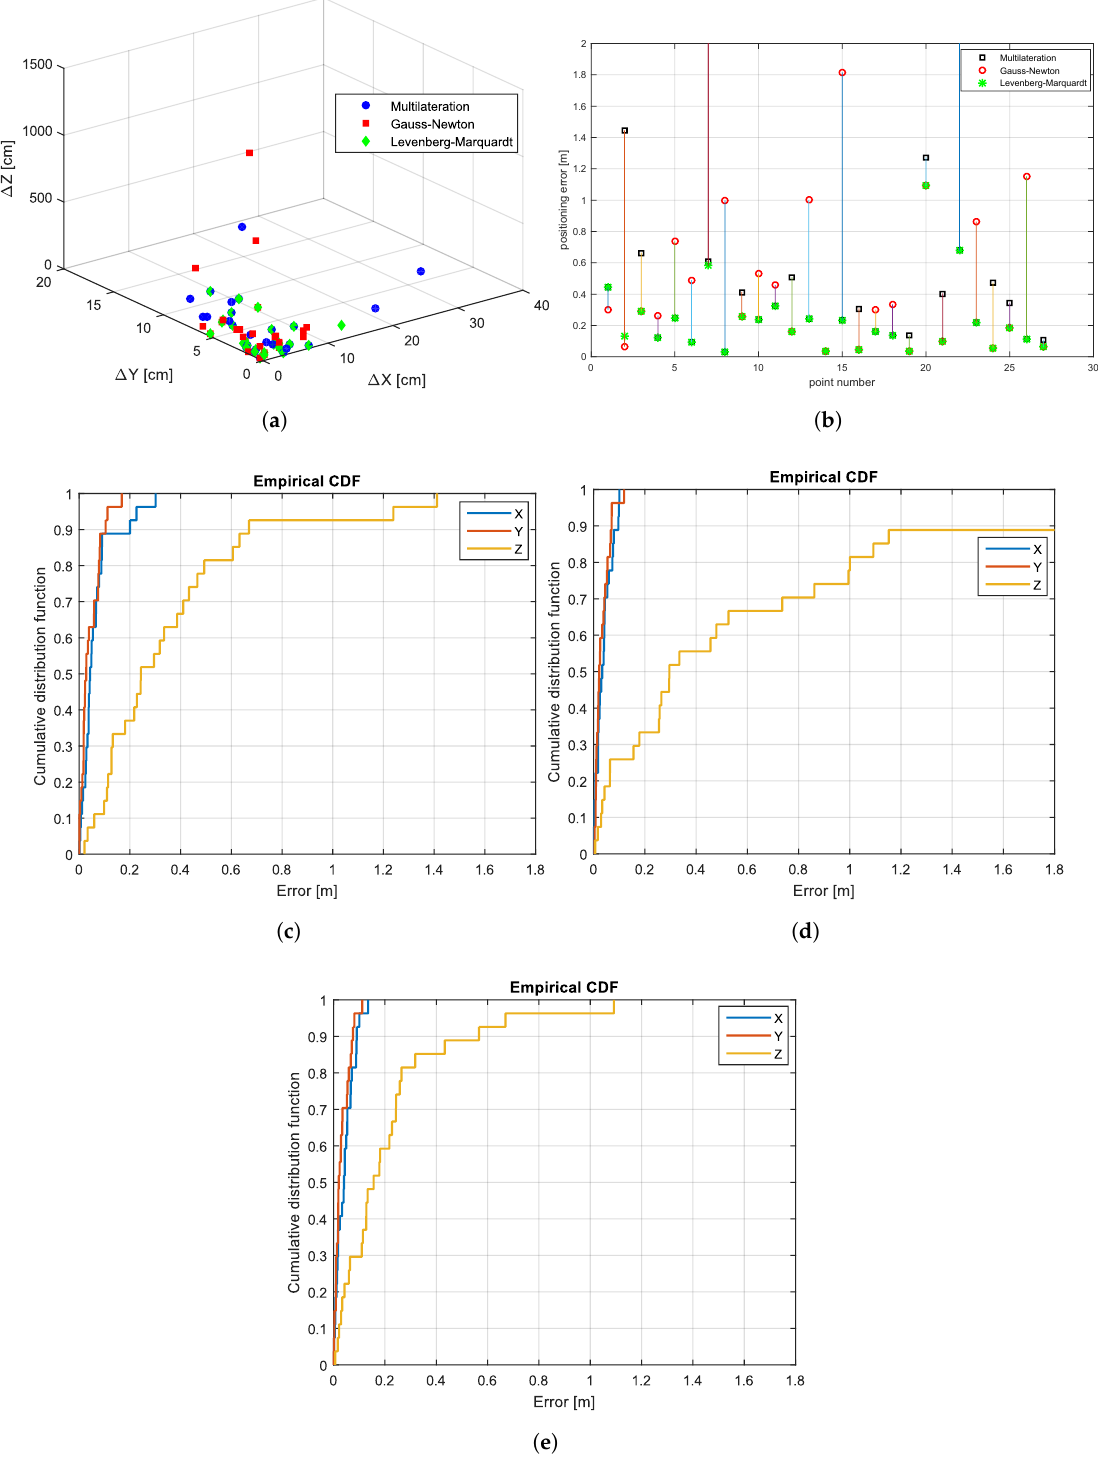
Figure 15. MILPS: scatter plots, position errors, and empirical CDFs. GNM, Gauss–Newton Method; ML, Multilateration; LVM, Levenberg–Marquardt Method. ( a ) Scatter plot of the ML, the GNM and the LVM, ( b ) position error of the ML, the GNM and the LVM, ( c ) CDF of the points estimated by the multilateration, ( d ) CDF of the estimated positions after GNM, ( e ) CDF of the estimated positions after